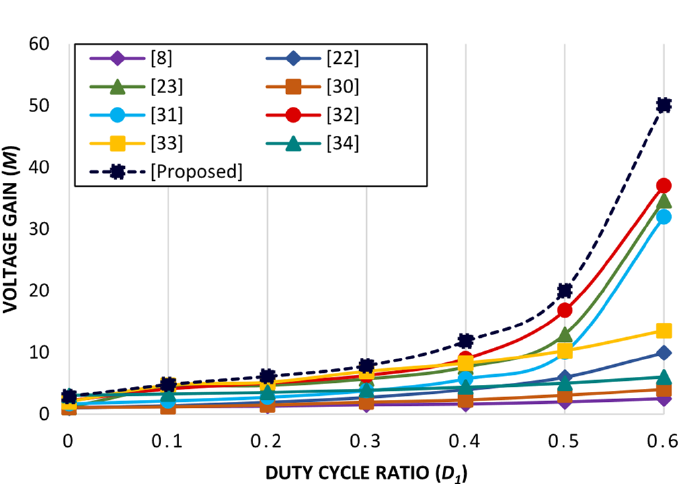
Figure 5 . Voltage gain comparison among various recently proposed DC–DC converters. Figure 5. Voltage gain comparison among various recently proposed DC–DC